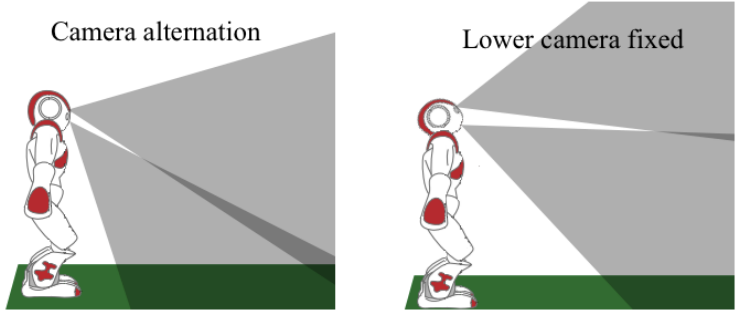
Figure 4. Different situations and camera modes: in the left picture, image information from both cameras is required, while in the right picture, only the lower camera is required.